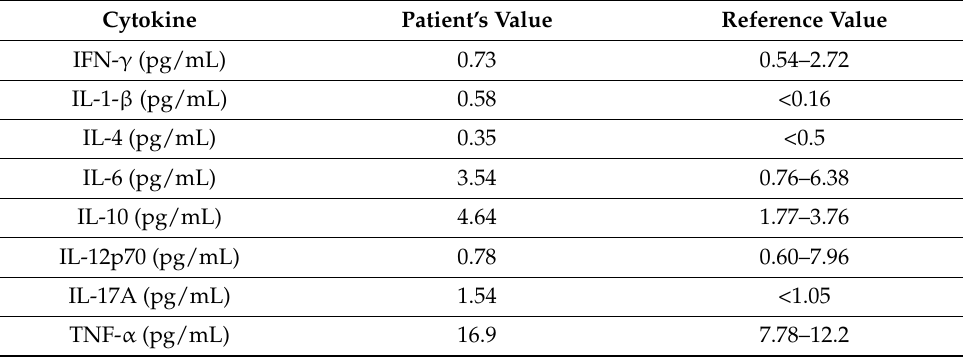
Table 2. Serum cytokine analysis.